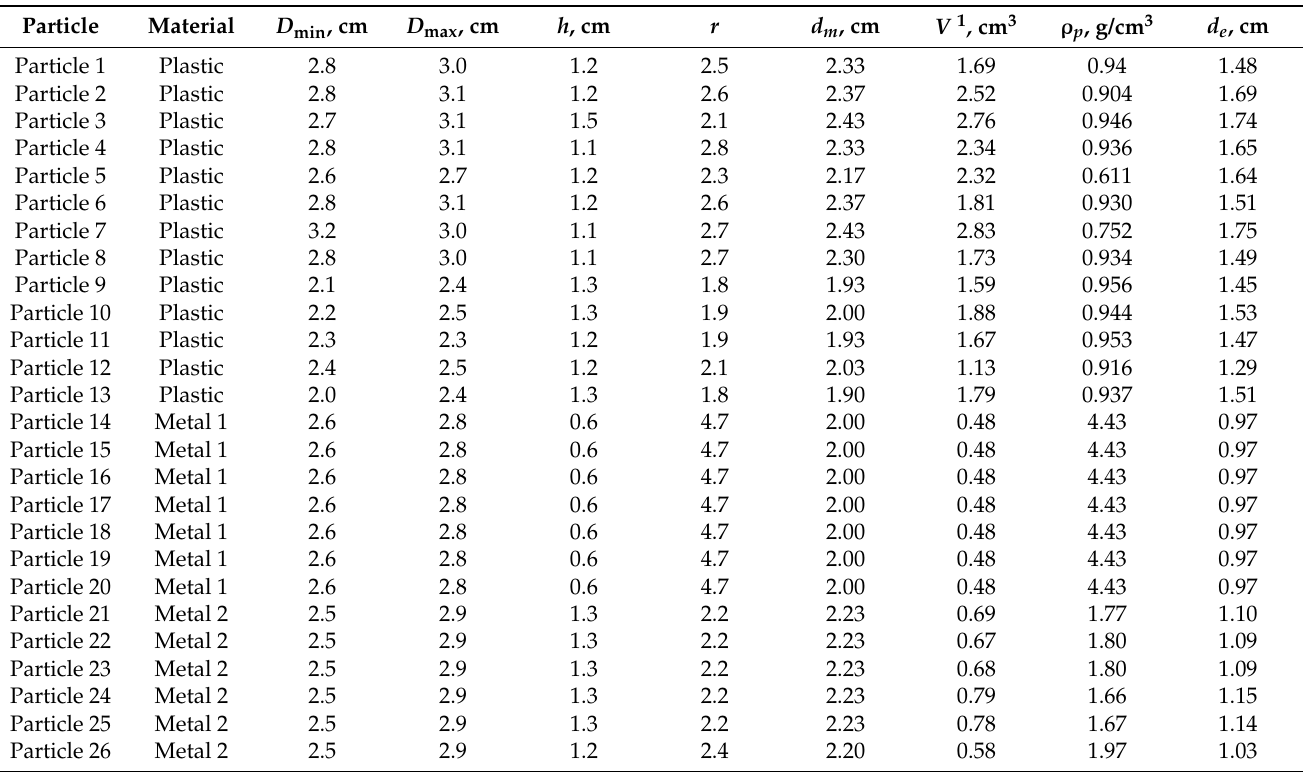
Table 1. Physical characteristics of the